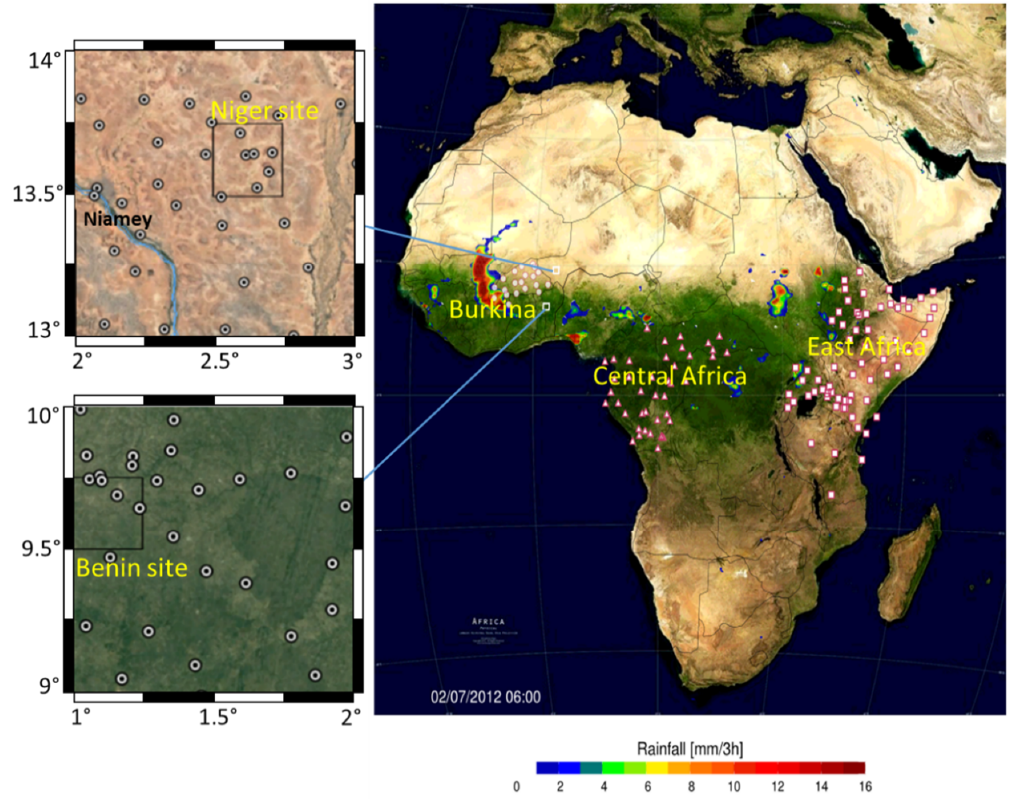
Figure 1. Location of the five reference, ground-based rainfall datasets: Burkina Faso (20 stations), Central Africa (42 stations), East Africa (78 stations) and the two AMMA-CATCH sites located in Niger (region of Niamey) and Benin (region of Nalohou). The two squares inside the two left graphs represent the two selected 0.25° pixels in Niger and Benin. Precipitation product on top of land cover on the right map illustrates a time step (3 h) of the PrISM precipitation product (2 July 2012 3 to 6 a.m.).